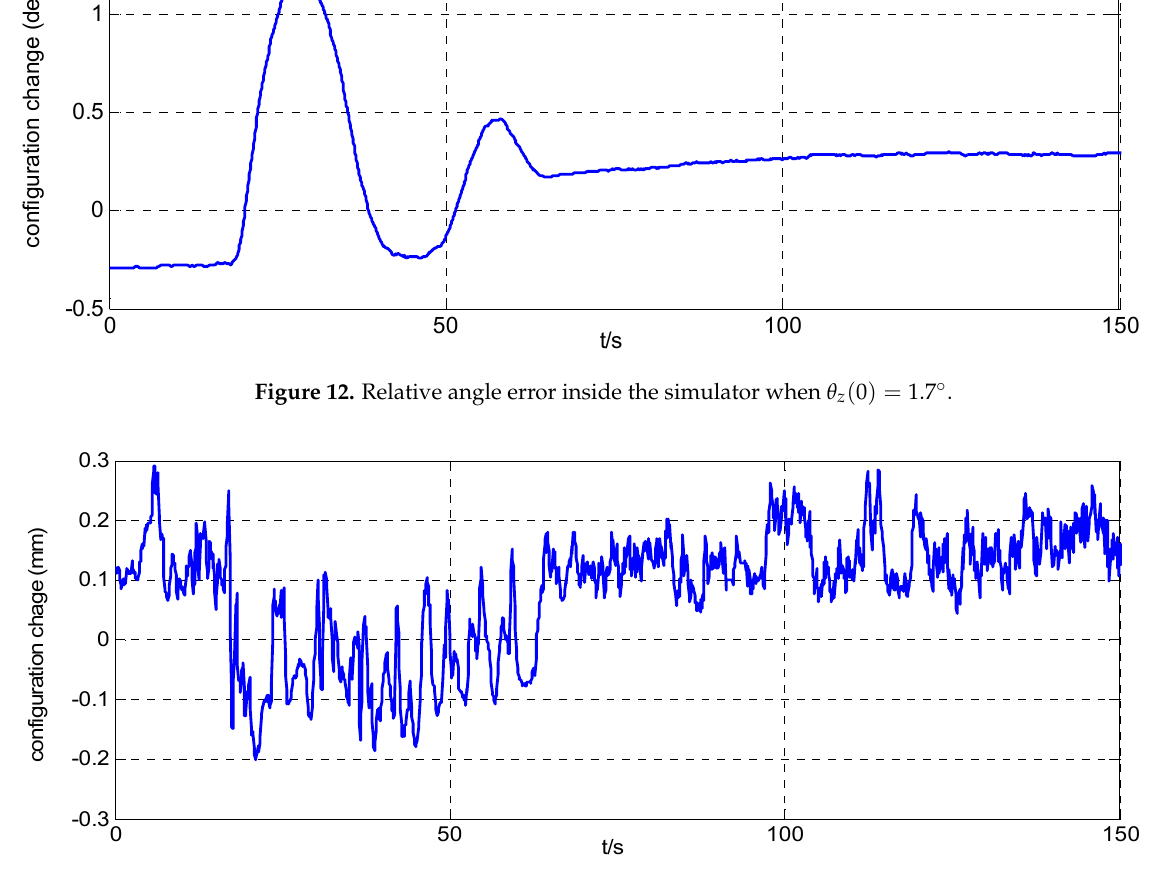
Figure 13. Relative position error inside the simulator when θ z ( 0 ) = 1.7 ◦